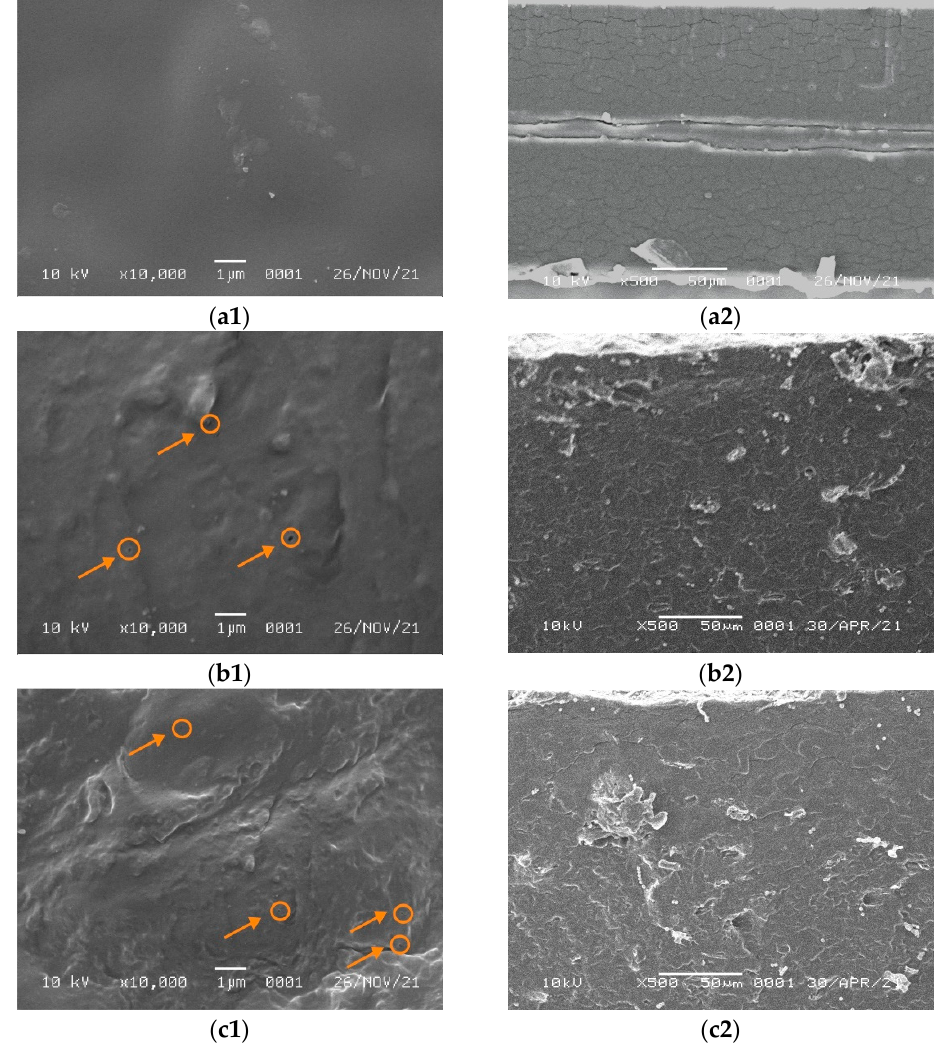
Figure 3. SEM micrographs of ( a1 ) WPI on the surface, ( a2 ) WPI on the cross section, ( b1 ) WPI/NCC 5% on the surface, ( b2 ) WPI/NCC 5% on the cross section, ( c1 ) WPI/NCC 7% on the surface and ( c2 ) WPI/NCC 7% on the cross section.